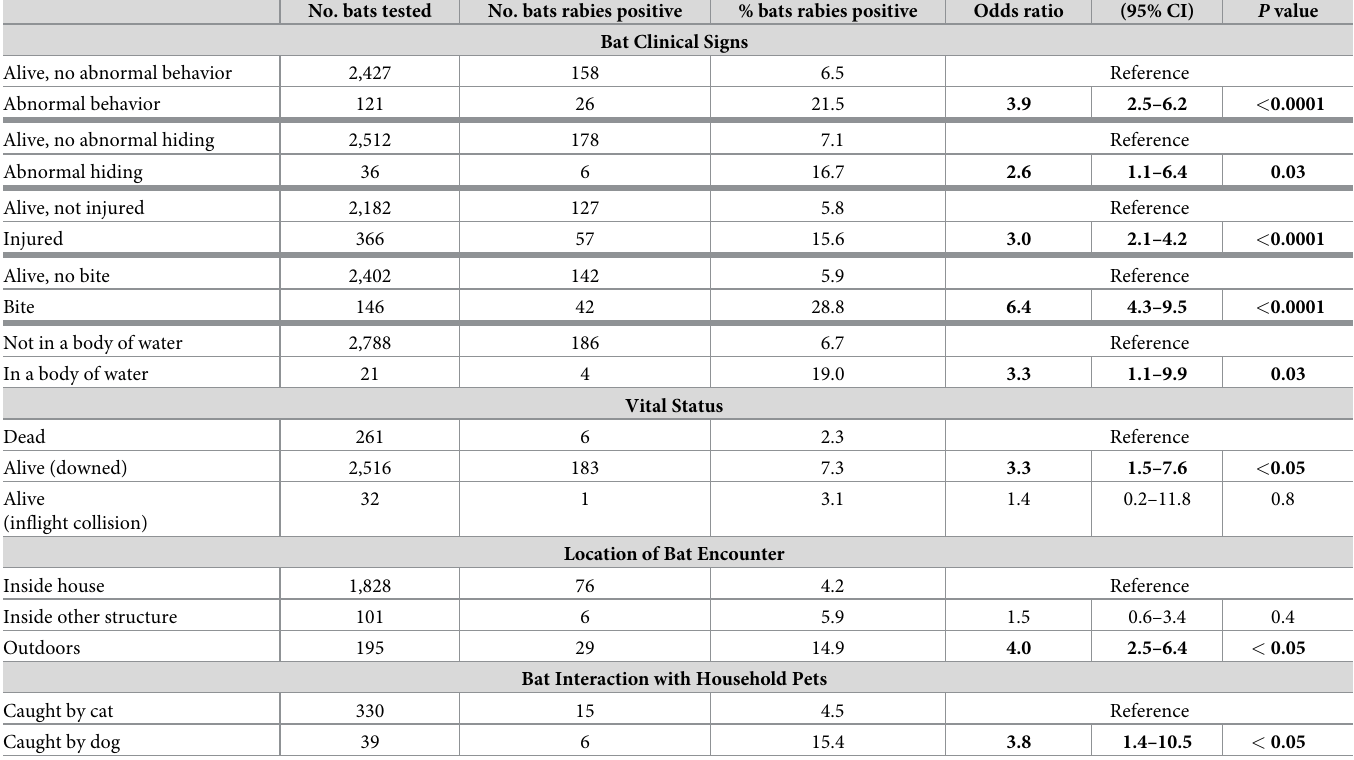
Table 3. Number of bats with definitive test result (N = 2,809), number and percent of bats positive for RABV, and odds ratio for RABV positivity, Washington State—2000–2016. Categories of bat signs and behaviors are not mutually exclusive. Bold font indicates statistical